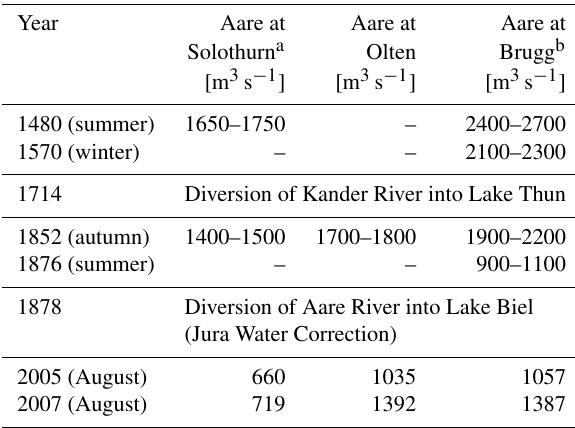
Table 1. Reconstructed historical (1480, 1570, 1852, 1876) and ob- served recent (2005, 2007) peak discharges for three sites along the Aare River (see Wetter, 2015; Baer and Schwab, 2020), as well as the most extensive changes made to the river network (1714, 1878) (see Vischer, 2003).